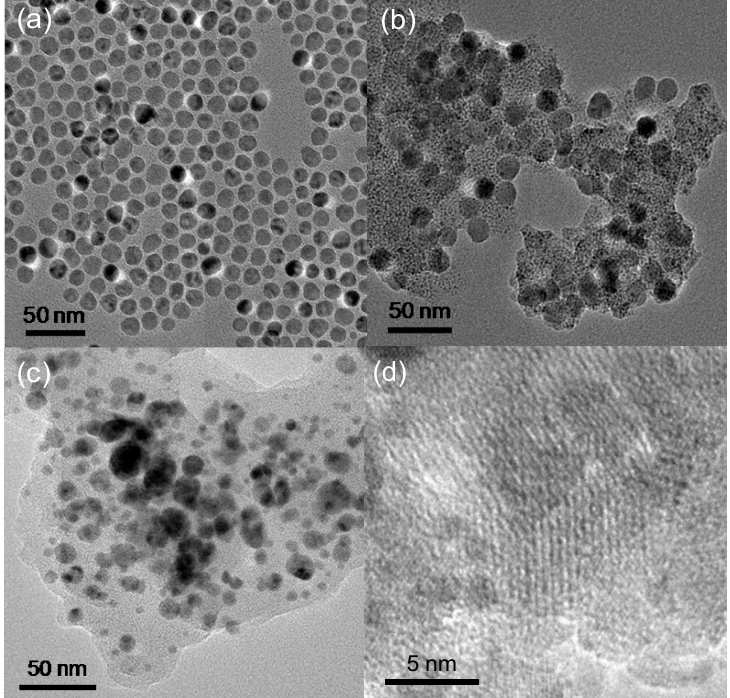
Figure 6. ( a ) TEM image of Fe 3 O 4 NPs; ( b ) TEM image of polymer composite catalyst; ( c ) TEM image of carbon composite catalyst; ( d ) HRTEM image of the porous carbon matrix. Reprinted with permission from